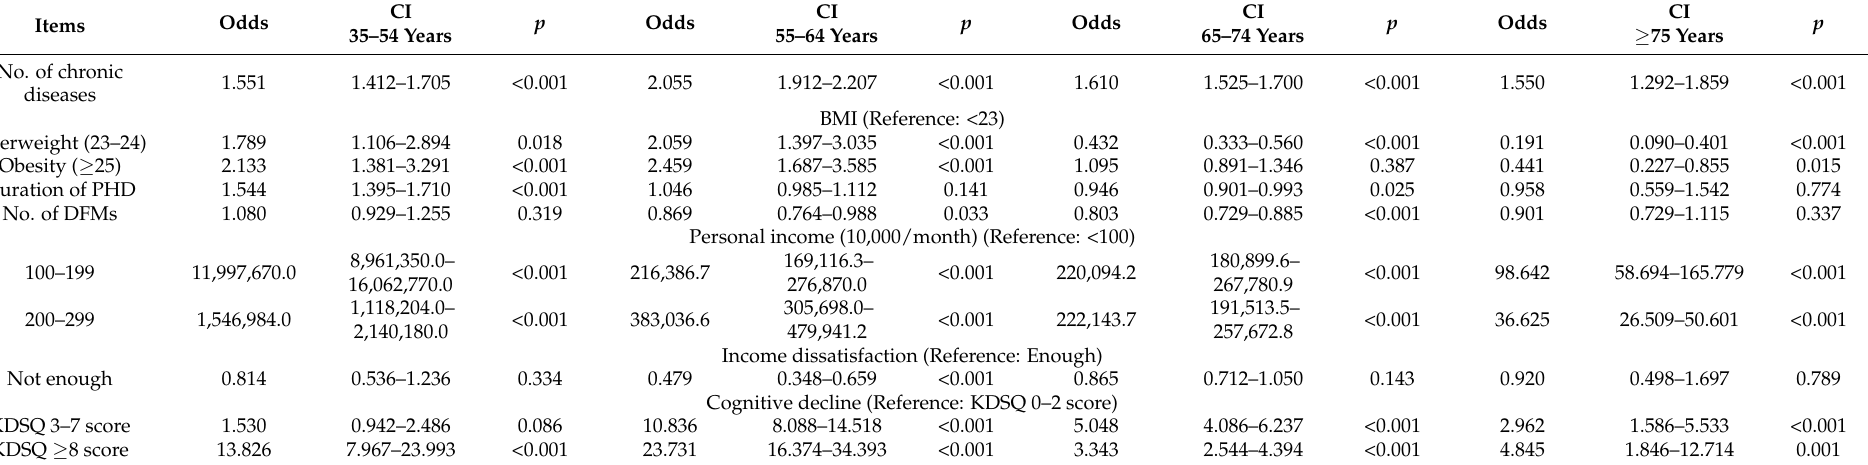
Table 2. Factors affecting deterioration of physical health status according to age group of taxi